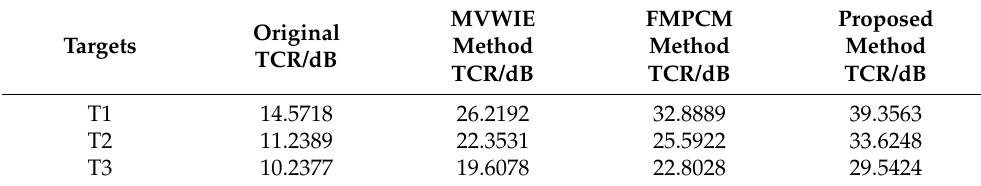
Table 2. TCR values calculated by different methods.